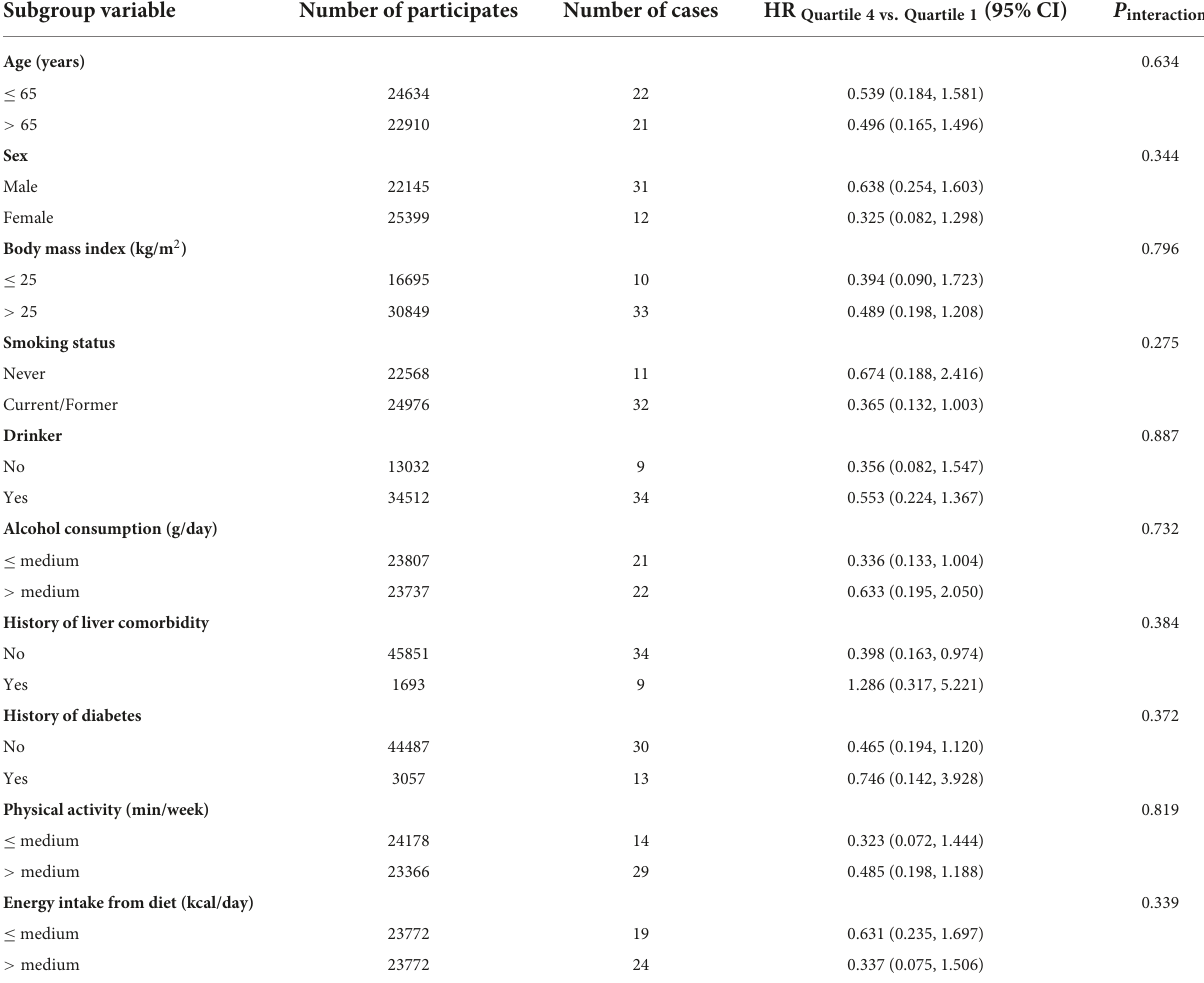
TABLE 4 Subgroup analyses on the association of low-fat diet score with the risk of liver cancer. Subgroup variable Number of